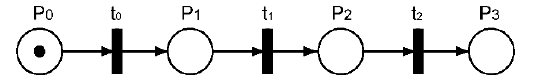
Figure 15. Petri net that describes the cross-connect process.